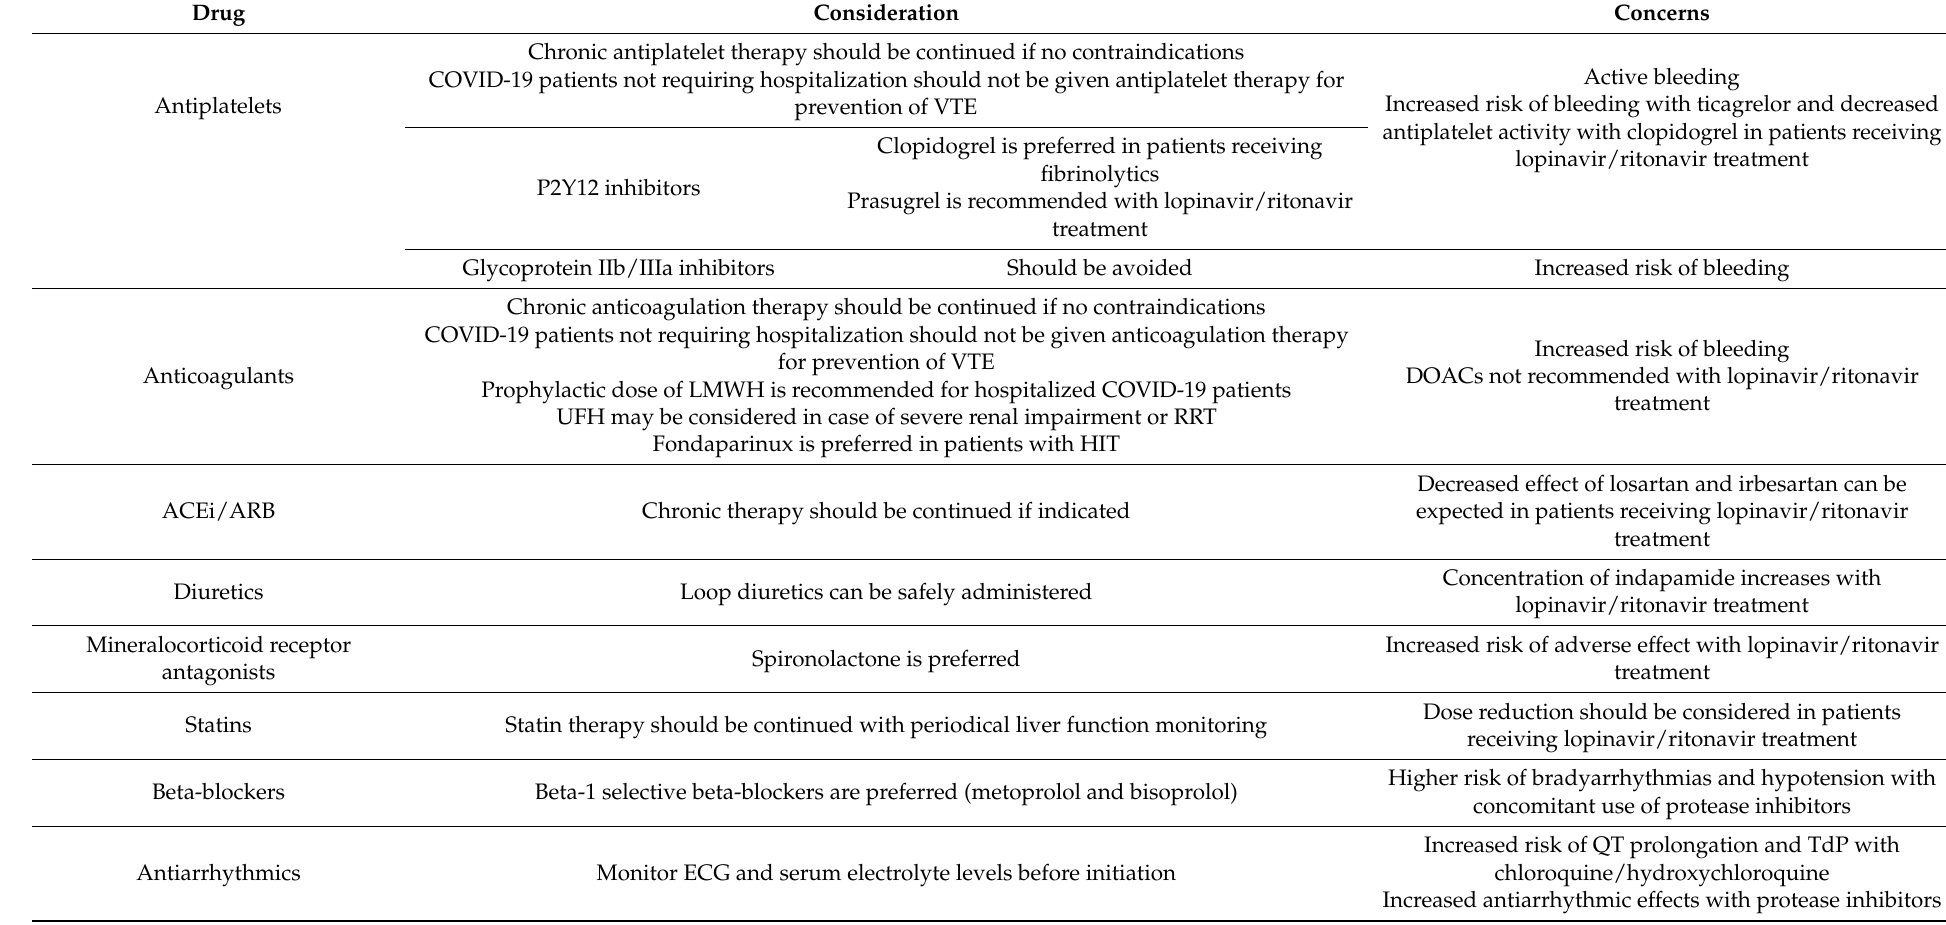
Table 2. Current therapeutic considerations and concerns with cardiovascular treatment in